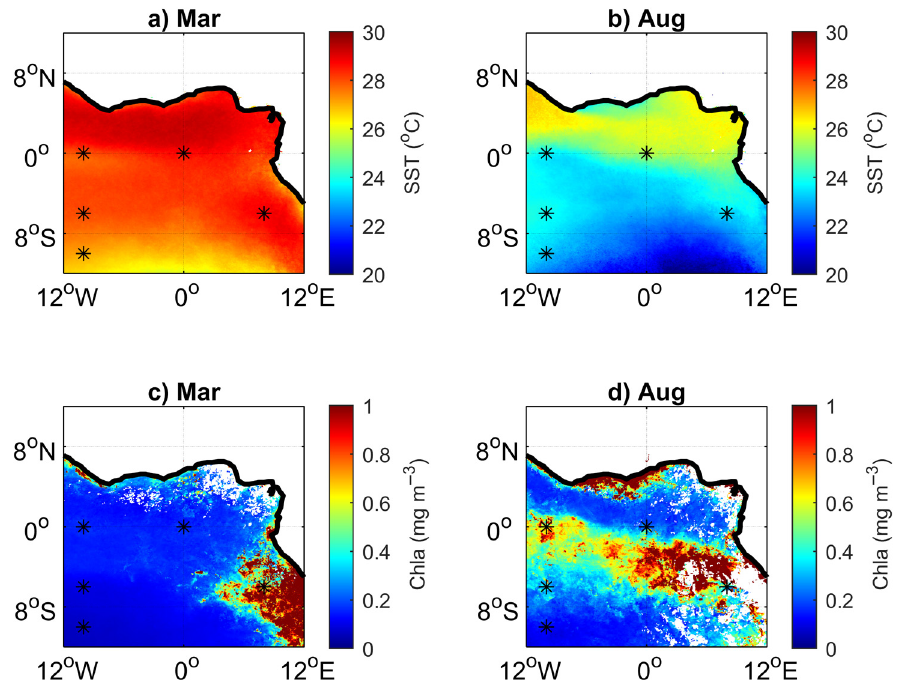
Figure 2. Distribution of the climatological sea surface temperature (SST) for ( a ) March and ( b ) August and chlorophyll a (Chla) for ( c ) March and ( d ) August from Moderate-Resolution Imaging Spectroradiometer (MODIS). The five PIRATA moorings are indicated by the black stars (*).